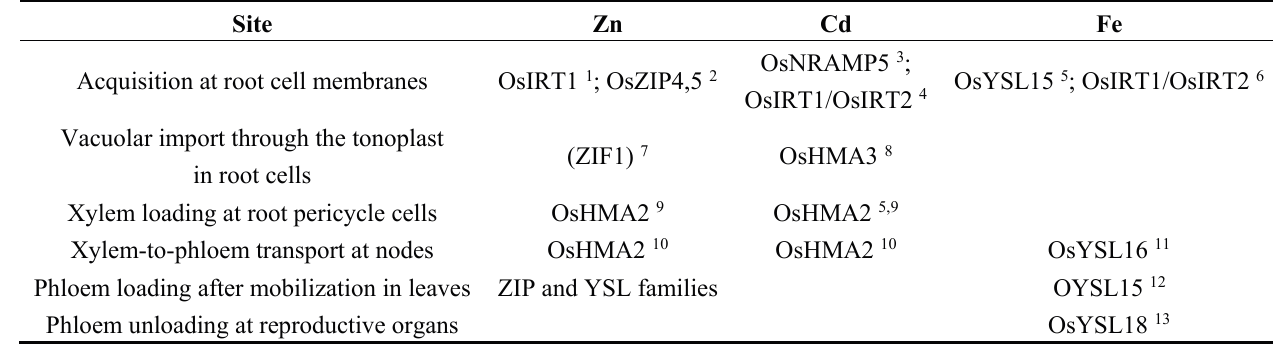
Table 2. Transporters involved in the acquisition and inter-organ transport of Zn, Cd, and Fe in rice